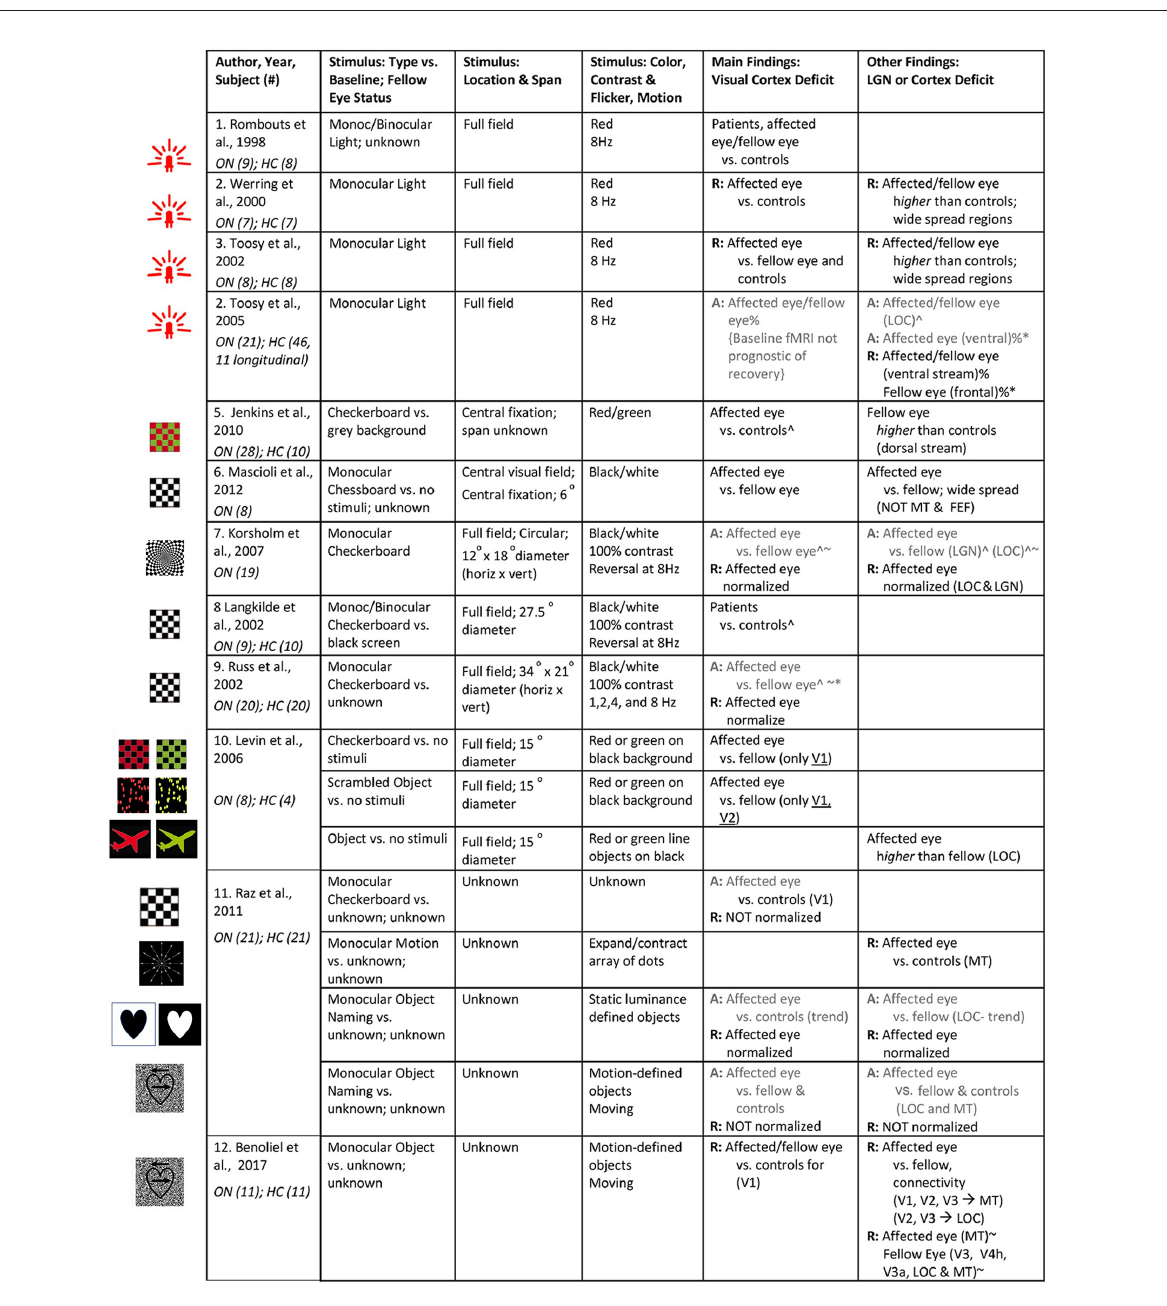
FIGURE4 Summary of visual stimuli utilized and findings in visually-driven fMRI studies of ON. The studies are listed based on the type of stimulus utilized. Left: Images of visual stimuli, similar to the ones utilized in each of the studies, have been provided. Note: Image in row 7 is licensed under a Creative Commons Attribution 4.0 International (https://creativecommons.org/licenses/by/4.0/, https://creativecommons.org/licenses/by/4.0/legalcode). It is attributed to Biological Psychiatry (https://www.sciencedirect.com/science/article/pii/S0006322307012413?via%3Dihub#fig1). A: Findings from ON patients in acute stage of disease (i.e., < 1 month from disease onset); R: Findings from ON patients in recovery or recovered stage of disease (i.e., > 3 months from disease onset); otherwise, results are obtained from mixed group of ON patients or time since onset unknown. ∧ Deficit indicated by correlation with visual sensitivity measures (i.e., BOLD activity declines with increasing severity measure). % Deficit indicated by correlation with optic nerve structural integrity (i.e., BOLD activity declines with increasing severity measure). % ∗ Compensation indicated by correlation with optic nerve structural integrity (i.e., BOLD activity increases with increasing severity measure). ∼ Deficit indicated by correlation with optic nerve conduction measures (shorter VEP latency/ higher amplitude) (i.e., BOLD activity declines with increasing severity measure). ∼∗ Compensation indicated by correlation with optic nerve conduction measures (shorter VEP latency/ higher amplitude; i.e., BOLD activity increases with increasing severity measure). Note: studies mentioned in rows 5–9 did not provide stimulus figures. We have added reference figures based on stimulus description. ON, optic neuritis; HC, healthy